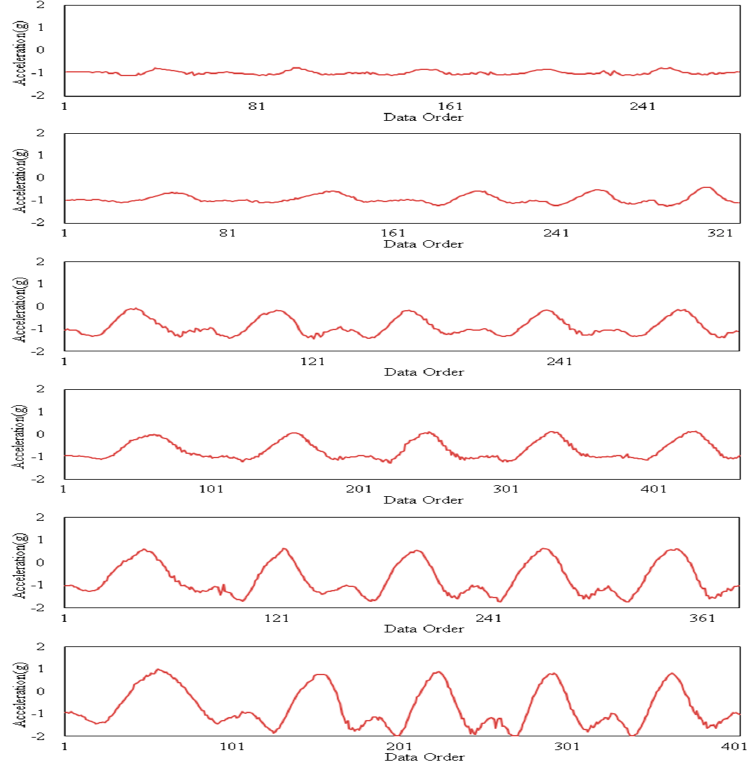
Figure 2. Flexion motion’s y -axis’s raw data from top to bottom ST2, ST3, ST4, ST5, ST6, and